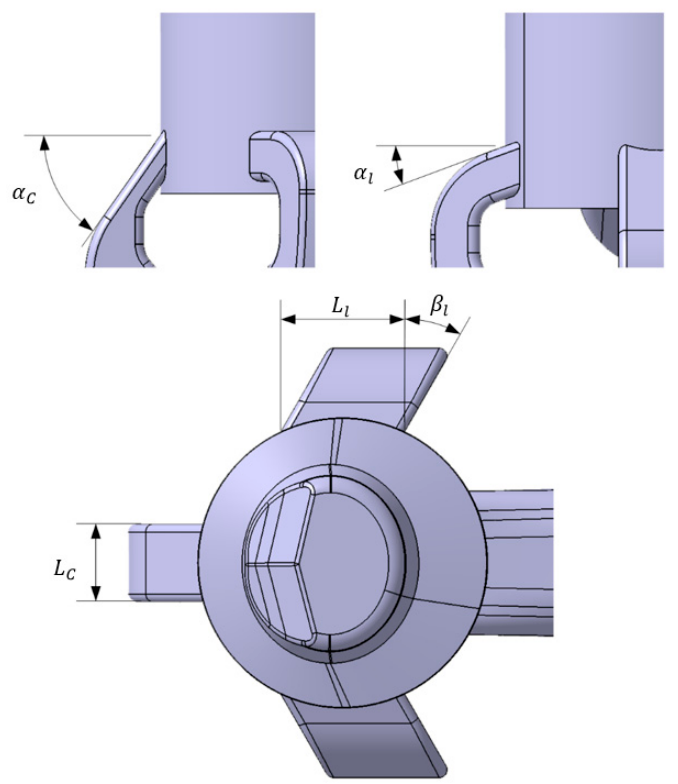
Figure 10. Definitions of important geometric parameters.